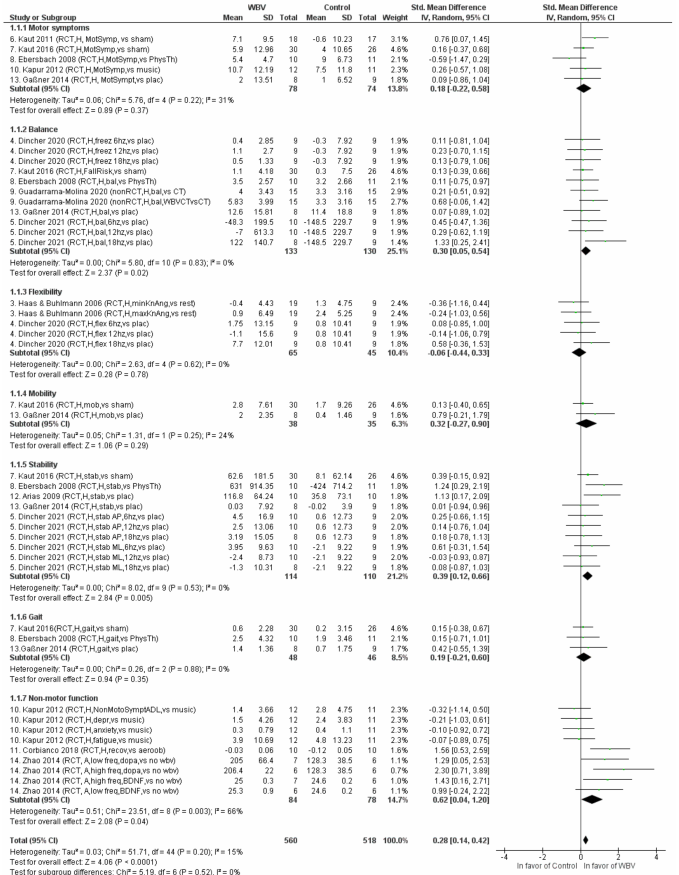
Figure 3. Forest plot with Hedges’ g effect sizes and 95% confidence intervals for motor and non-motor symptoms in PD populations (research question 1). Abbreviations: RCT = randomized controlled trial; H = human study; A = animal study; MotSymp = motor symptoms; Sham = sham vibration; PhysTh = physiotherapy; Plac = placebo; Freez = freezing; Bal = balance; CT = conventional ther- apy; MinKnAng = minimum knee angle; MaxKnANG = maximum knee angle; Flex = flexibility; Mob = mobility; Stab = stability; AP = anterior–posterior; ML = medio-lateral; NonMotoSymp- tADL = non-motor symptoms during activities of daily living; Aerob = aerobic treadmill training; Depr = depression; Recov = recovery phase; Dopa = dopamine; BDNF = brain-derived neurotrophic